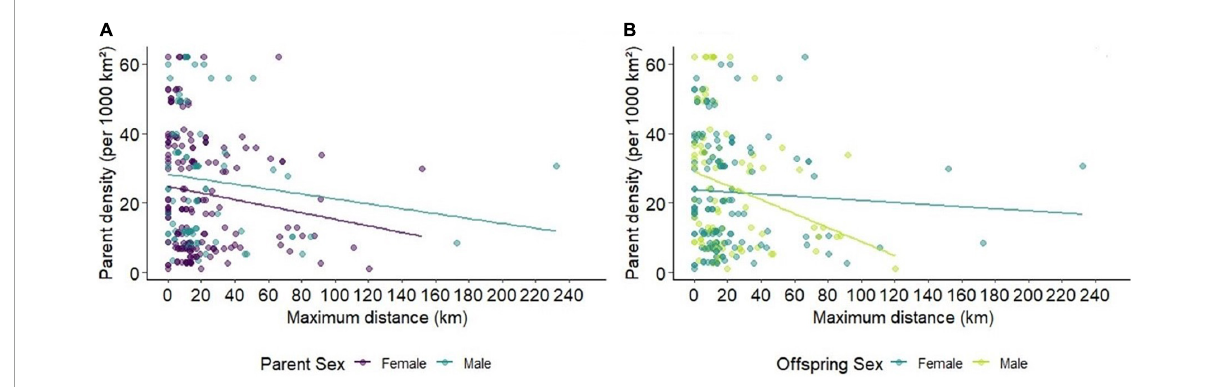
FIGURE4 Frequency of maximum dispersal distances between parents and offspring by parent sex (A) . Distribution of maximum dispersal distances versus density at the parent location by (A) parent sex and (B) offspring